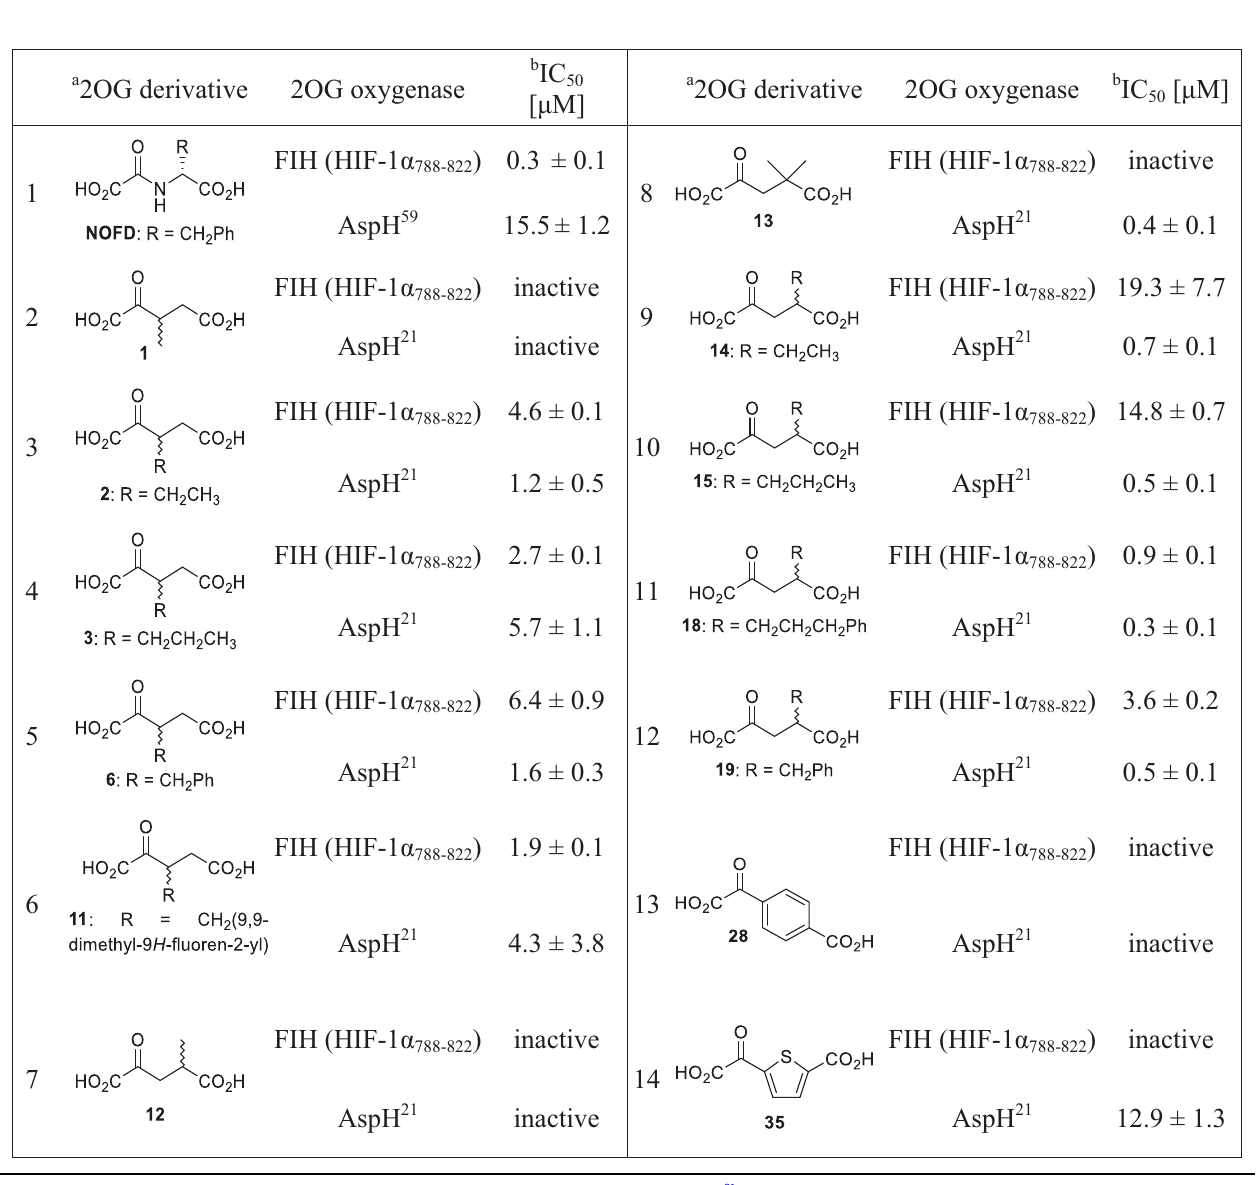
Table 3 Synthetic 2OG derivatives inhibit